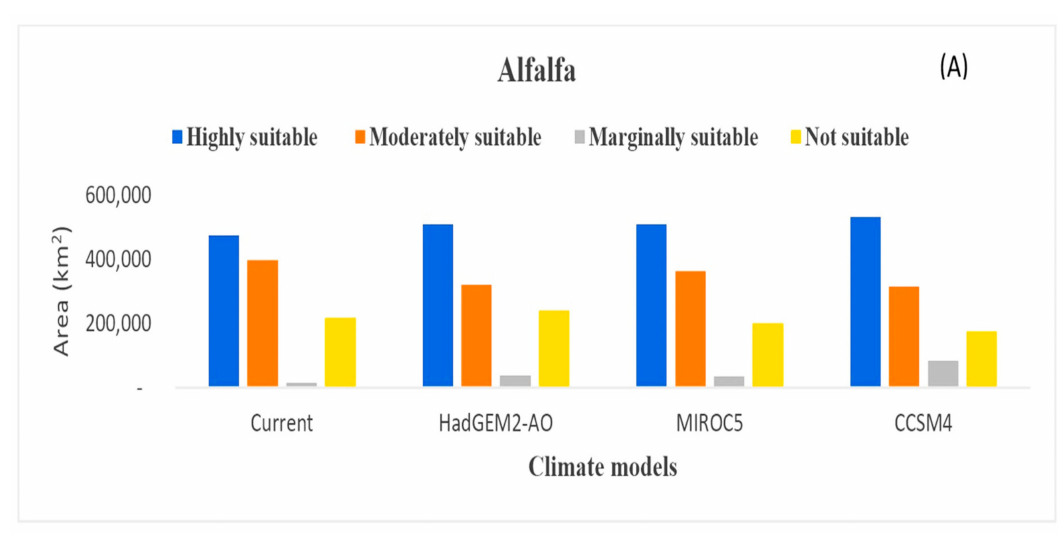
Figure 7. Results of the land area (km 2 ) classified as highly, moderately, and marginally suitable using multi-criteria evaluation (MCE) and analytical hierarchy process (AHP) methods. The specie evaluated under current climate (1970–2000) and three global circulation models (HadGEM2-AO, MIROC5, and CCSM4,) representing the 4.5 representative concentration pathway (RCP) for the period of 2041–2060 in